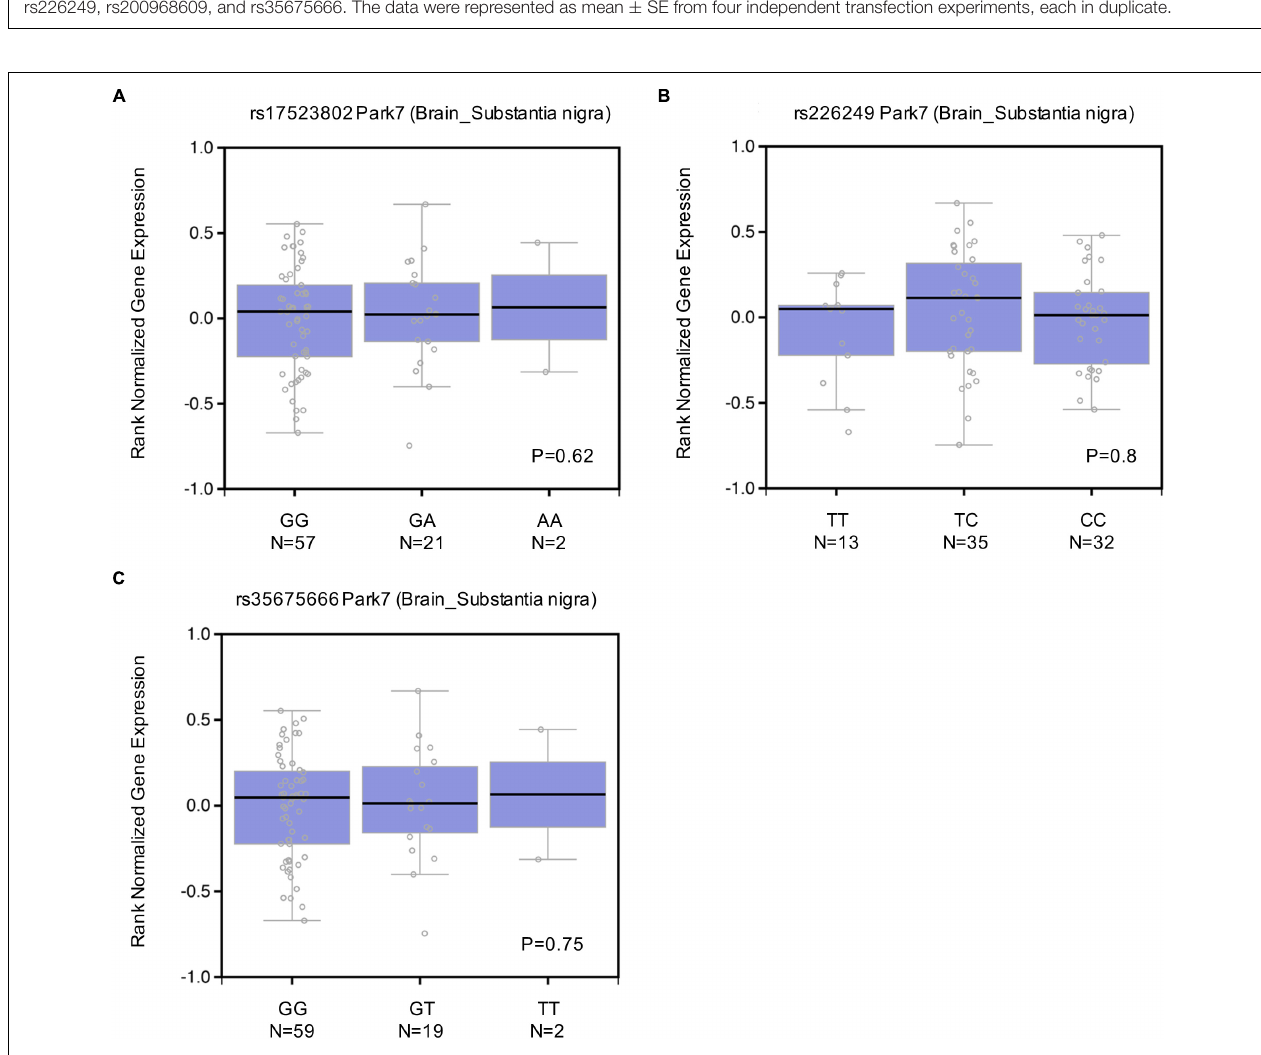
FIGURE 4 | Effect of rs17523802 (A) , rs226249 (B) , rs356756666 (C) genotype on DJ-1 mRNA expression in normal human brain substantia nigra. Data of rs200968609 were not found in dbGap.